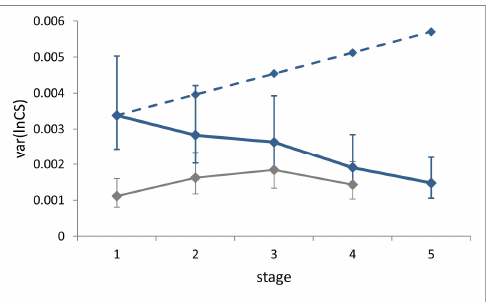
Figure 4. Ontogenetic progression of size variance (var( lnCS )) during the five larval stages in P. brassicae . Continuous blue line, field dataset; grey line, laboratory dataset (from [8]). The dashed line is the expected progression of size variance in the absence of compensation for the field dataset. Bars are 95% confidence intervals.